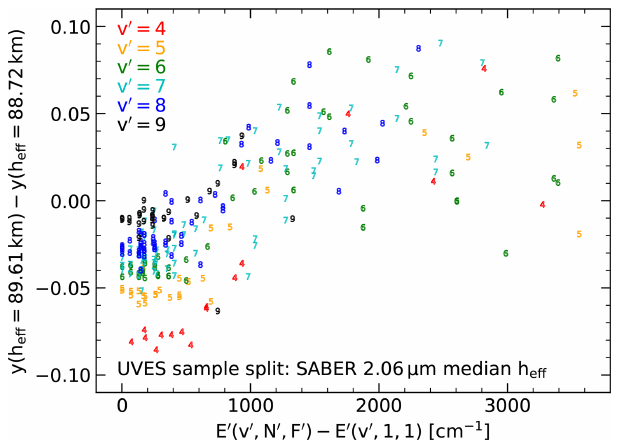
Figure 14. Difference in logarithmic OH level populations for UVES mean spectra based on equally sized subsamples of high and low effective emission height (89.61 and 88.72km on average). The altitudes were derived from volume emission profiles of the SABER OH channel at 2.06µm for the Cerro Paranal region. The data points are shown for different upper vibrational levels v (cid:48) (indicated by the corresponding coloured markers) as a function of the level energies in inverse centimetres relative to the lowest v (cid:48) -related energy. The plot only shows population measurements for reliable (cid:51) doublets which are covered by both UVES set-ups (see Fig. 1 for the valid wavelength